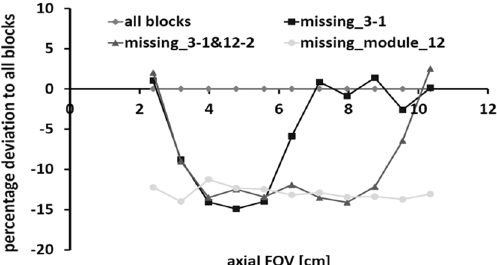
Fig. 5 Percentage deviation along the axial field of FOV for the three investigated cases (one block missing, two blocks missing, and four blocks missing) based on when all blocks are present, revealing substantial deviations